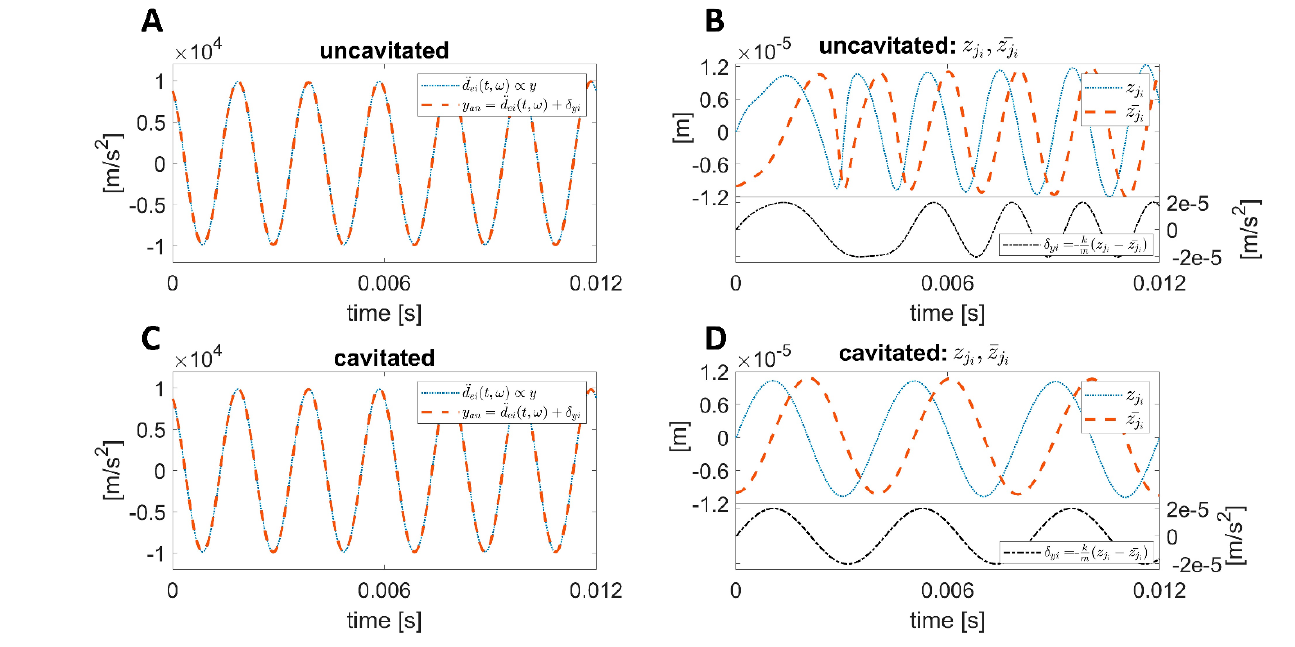
.. Figure 9. Scalar analytical output noise (cid:1877) (cid:3028)(cid:3041) and actual disturbance component (cid:1856)(cid:4663) (cid:3032)(cid:3036) ((cid:1872), (cid:2033)) for d ei ( t , ω ) for uncavitated Figure 9. Scalar analytical output noise y an and actual disturbance component uncavitated and cavitated conditions ( A , C ); “ (cid:1861) ” component of actual journal displacement (cid:1878) (cid:3037) and (cid:3284) and cavitated conditions ( A , C ); “ i ” component of actual journal displacement z j and its analytically with the scaled difference (cid:2012) (cid:3052)(cid:3036) for uncavitated and cavitated its analytically reconstruction (cid:1878) (cid:3115) (cid:3365) i (cid:3036) reconstruction z Ji with the scaled difference δ yi for uncavitated and cavitated conditions ( B , D conditions ( B , D ).